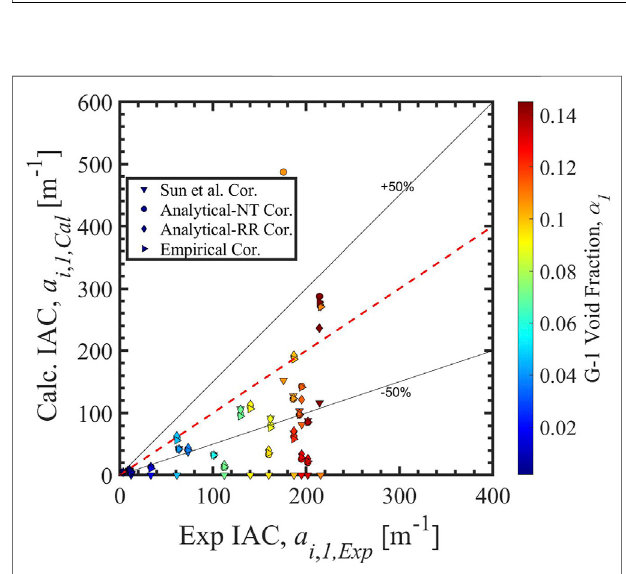
Frontiers in Energy Research |